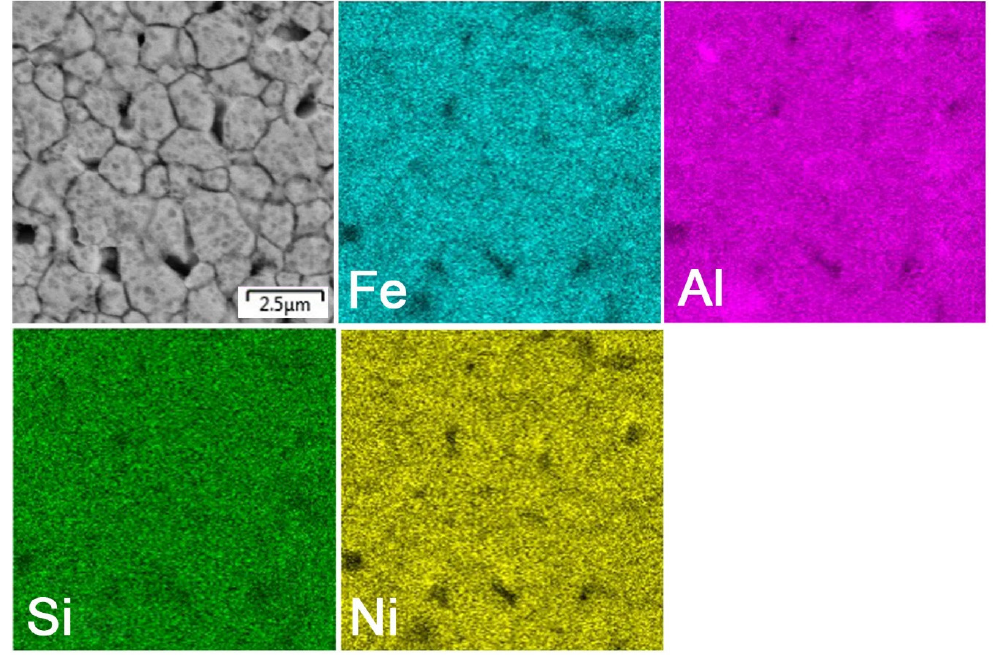
Figure 4. EDS elemental map of the bulk FeAl35Si5Ni20 alloy.